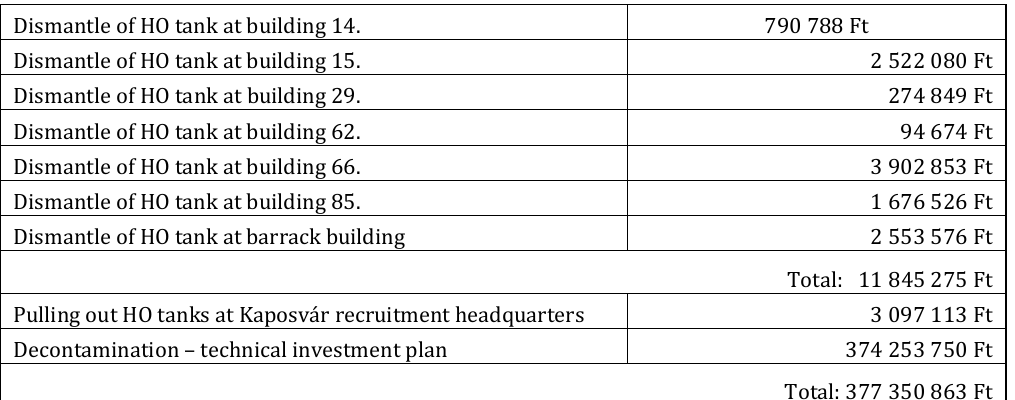
Table 6. Planned cost decontamination and disassembly of Heating Oil Tanks (Source: author’s edit based on the table from findings of Gyovai-B. R., 2015, information from Ministry of Defence, Bureau of Defence Economics, Directorate of Infrastructure, Department of Real Estate Development and Environmental Protection Dismantle of HO tank at building 14. Dismantle of HO tank at building 15. Dismantle of HO tank at building 29. Dismantle of HO tank at building 62. Dismantle of HO tank at building